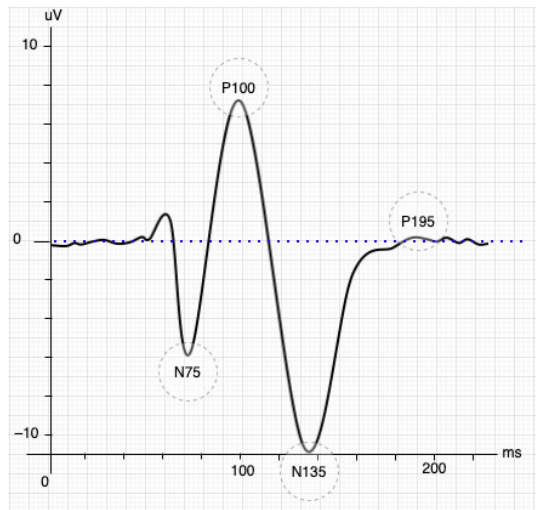
Figure 1. Stimulation of the inverted pattern of the SSVEP signal